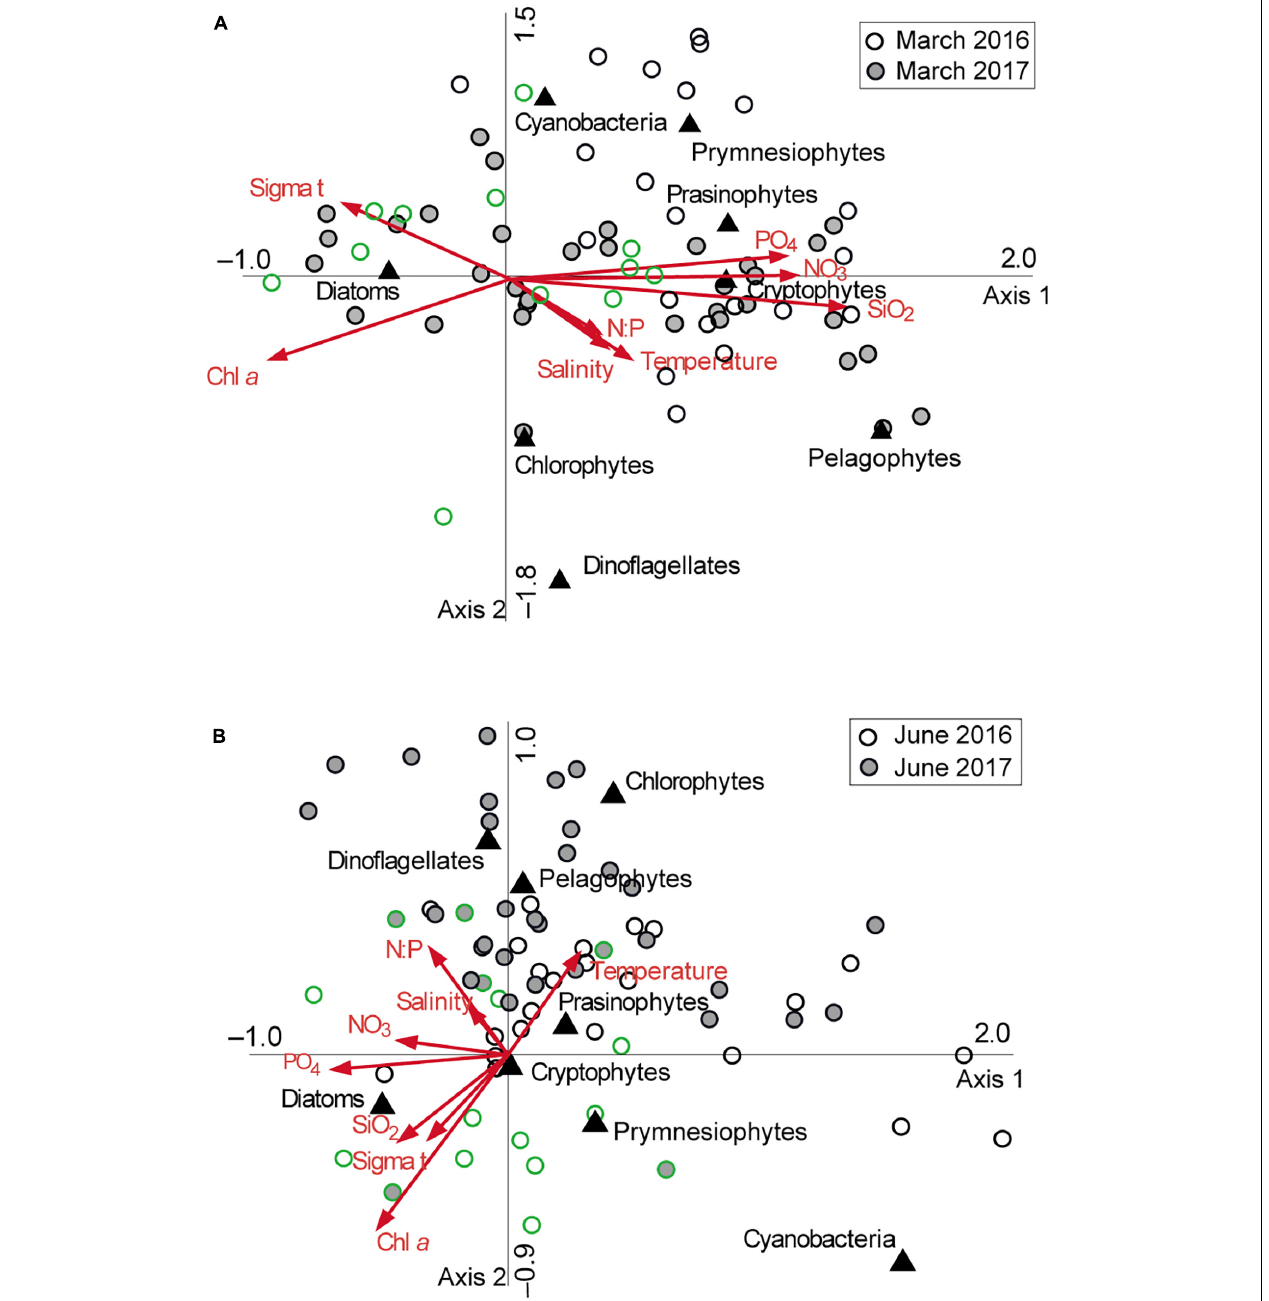
FIGURE 9 | Canonical correspondence analysis: ordination diagrams of phytoplankton abundance and composition data at various station/depth combinations with environmental variables represented by arrows in panel (A) March and (B) June 2016 and 2017, respectively (see text for explanation). Phytoplankton classes are shown by filled triangles. Green symbols represent the samples with chlorophyll a (Chl a ) concentrations > 1 µ g l - 1 .